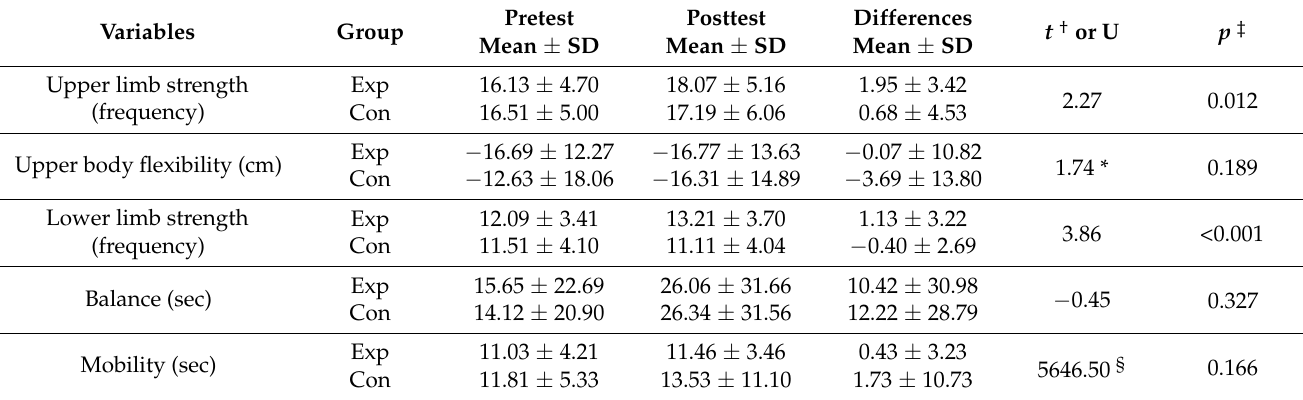
Table 4. Comparing the effects of the physical exercise program on physical